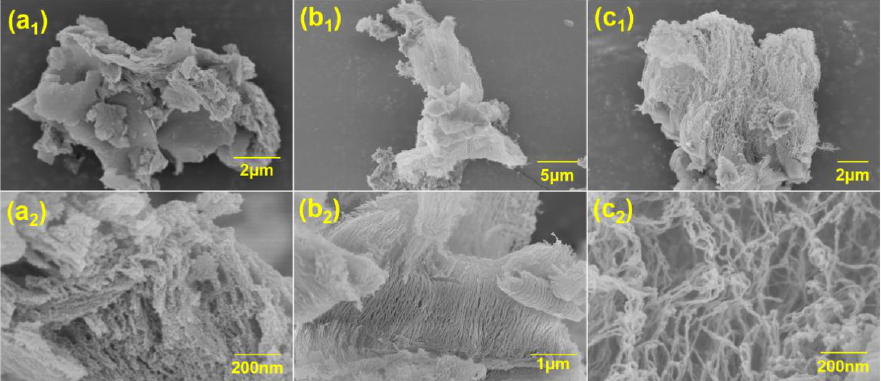
Figure 10. SEM images of final products of ( a 1 ) 0% NiCl 2 (1 h), ( a 2 ) amplified image of a 1 ; ( b 1 ) 2% NiCl 2 (1 h), ( b 2 ) amplified image of b 1 ; ( c 1 ) 2% NiCl 2 (2 h), ( c 2 ) amplified image of c 1 .